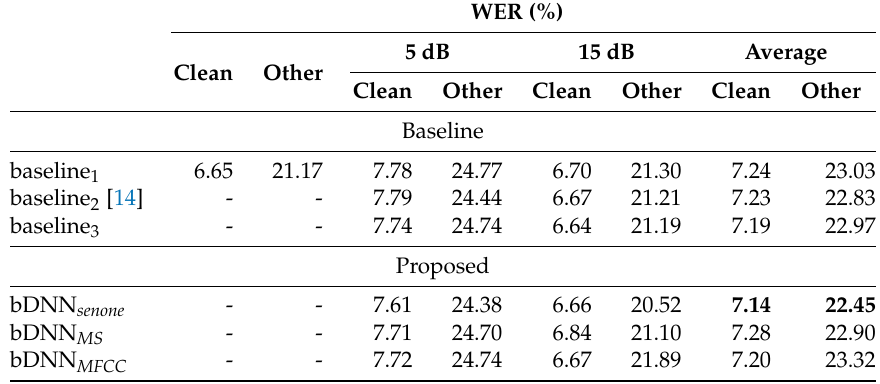
Table 3. Performance (WER in %) comparison using LibriSpeech database with 4-gram language model when the motor is